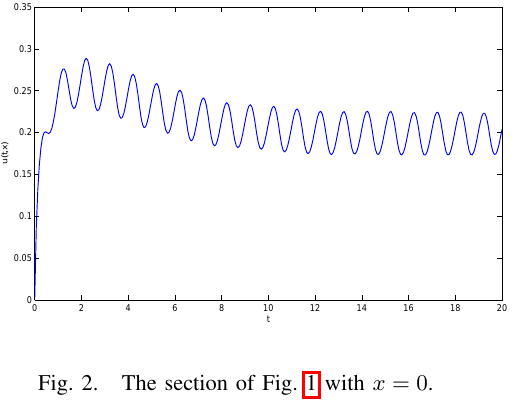
Fig. 2. The section of Fig. 1 with x = 0 .